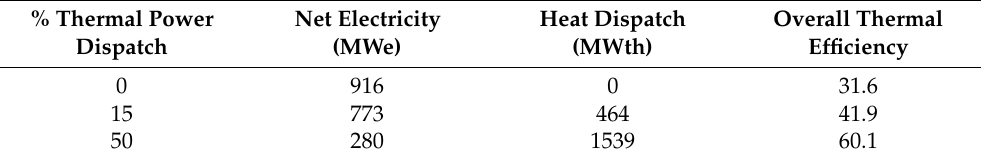
Table 2. Electrical and thermal power dispatch amounts and overall thermal efficiency at varying amounts of thermal power